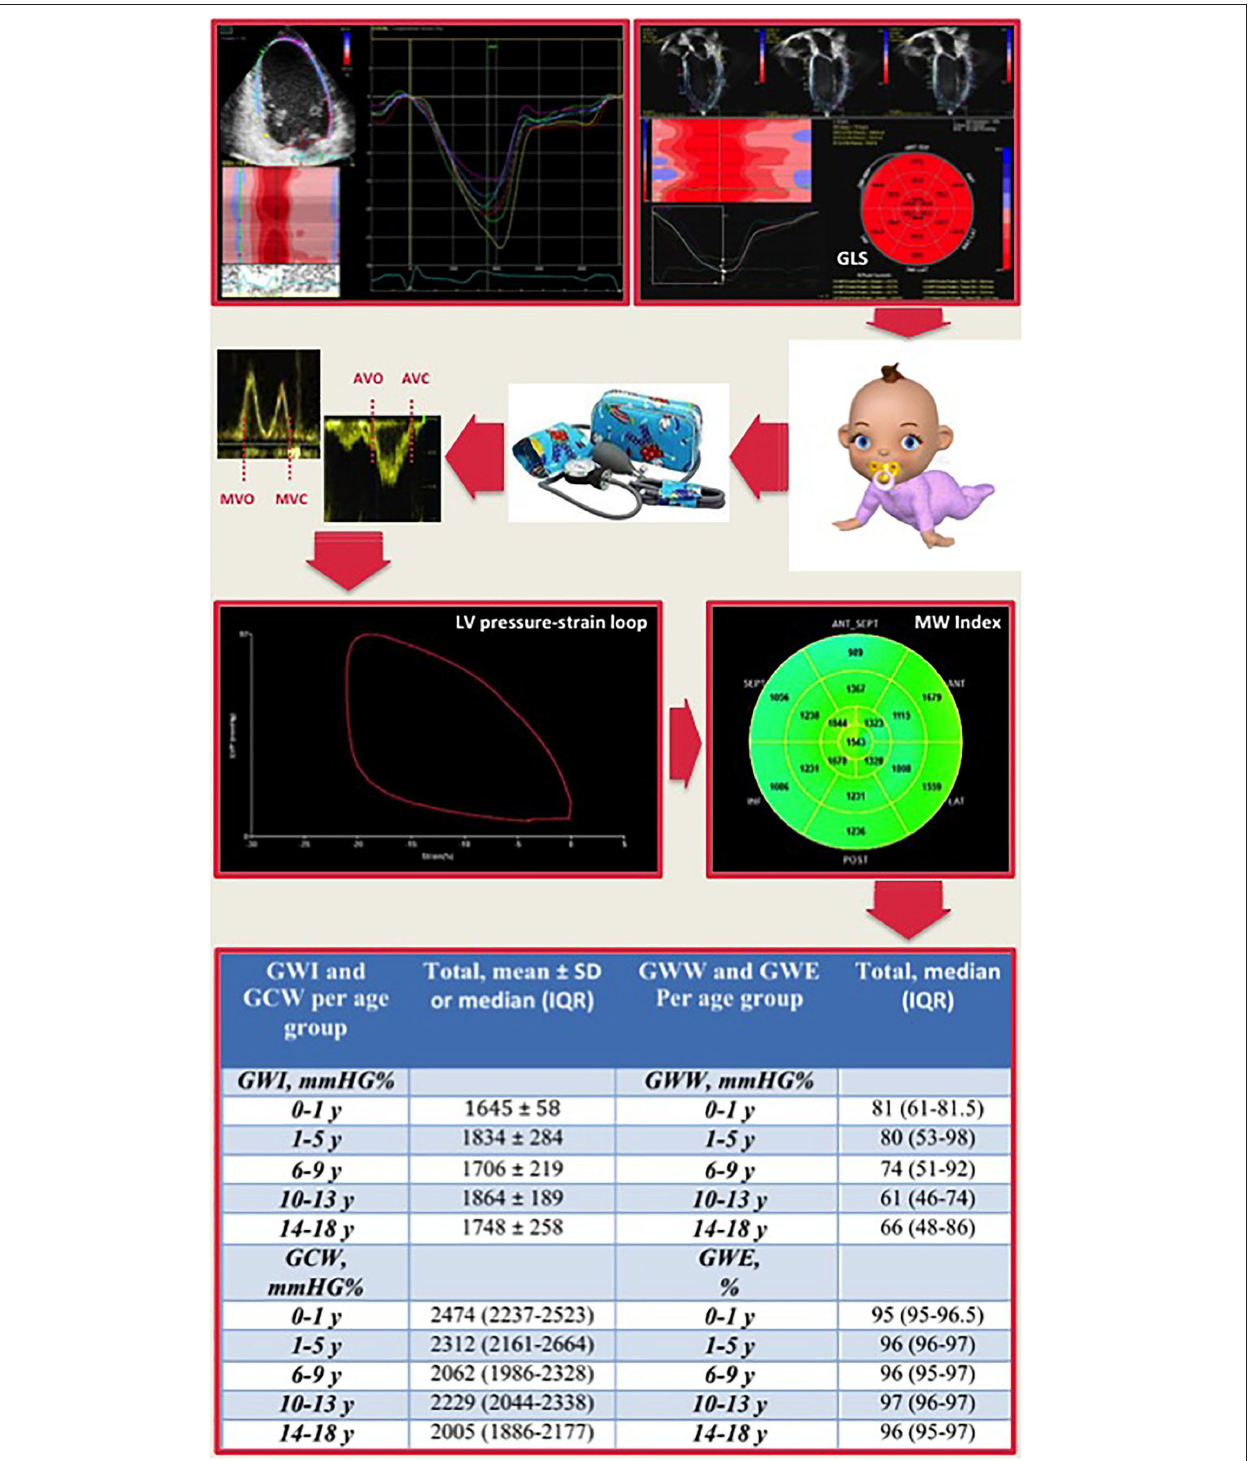
FIGURE 3 | Representative schema of myocardial work calculation with reference cut-off values for age subgroups. LV global longitudinal strain measurement combined with the non-invasive blood pressure systolic and diastolic values, obtained by a brachial-cuff aneroid sphygmomanometer, is plugged into dedicated software. The time of opening and closure of the aortic and mitral valve is identified by the operator. Then, a trace showing the LV pressure-strain loop and a 17-segment bull’s-eye of the MW index is calculated. At the bottom, the table resumes the normal reference ranges for each myocardial work parameter in the overall population and for each age group. GLS, global longitudinal strain; AVC, aortic valve closure; AVO, aortic valve opening; MVC, mitral valve closure; MWO, mitral valve opening; LV, left ventricular; MW, myocardial work.